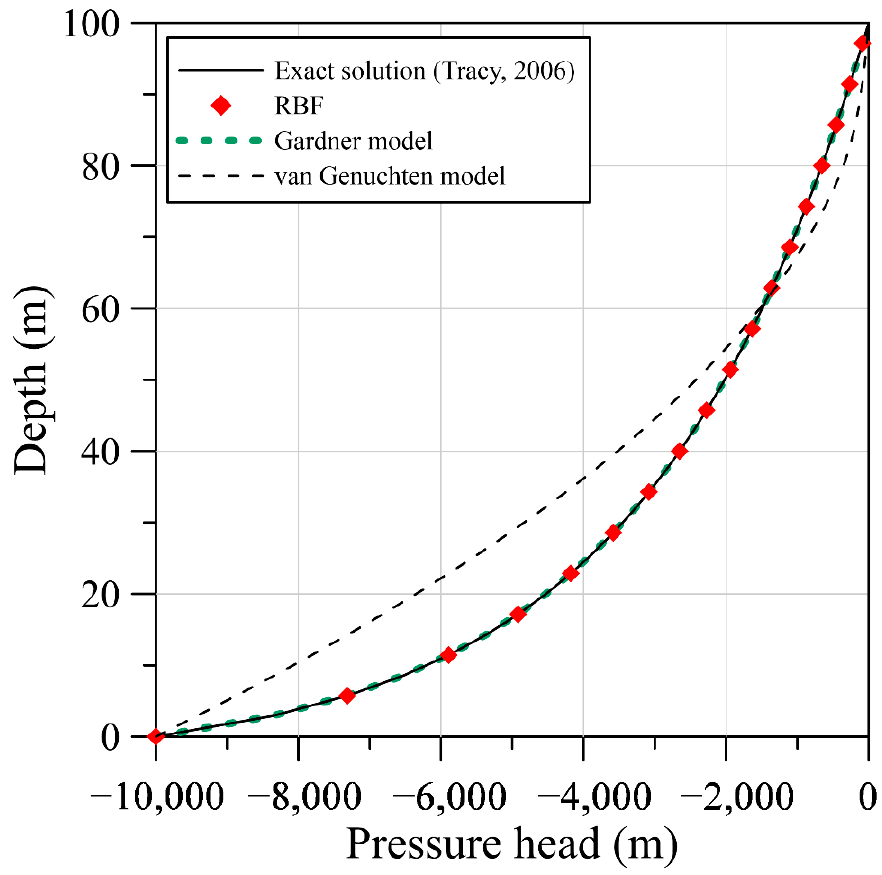
Figure 7. Comparison of the pressure head with the exact solution.